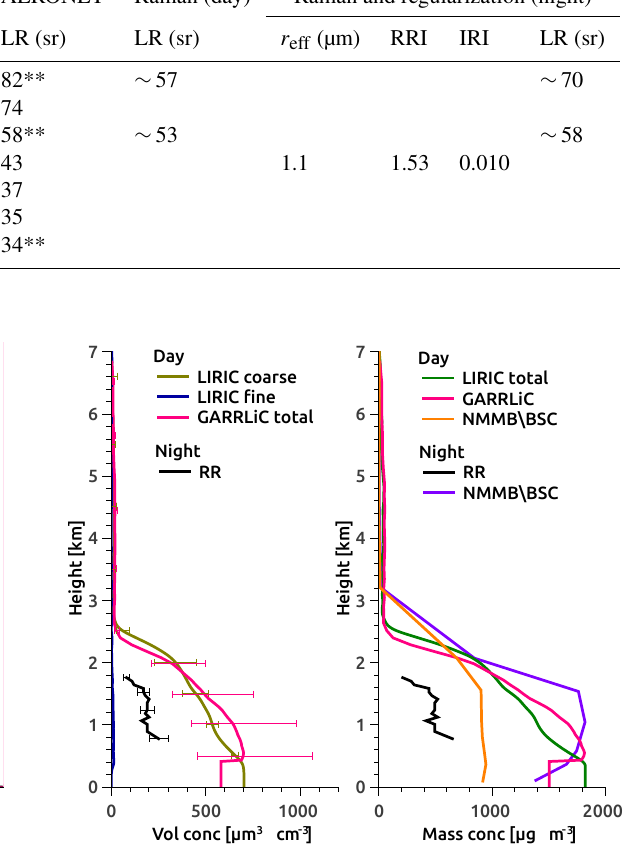
Figure 8. Volume (Vol conc) and mass (Mass conc) concentration profiles for an event over the Dakar site on 29 March 2015. The abbreviation RR corresponds to V retrieved by using Raman and regularization